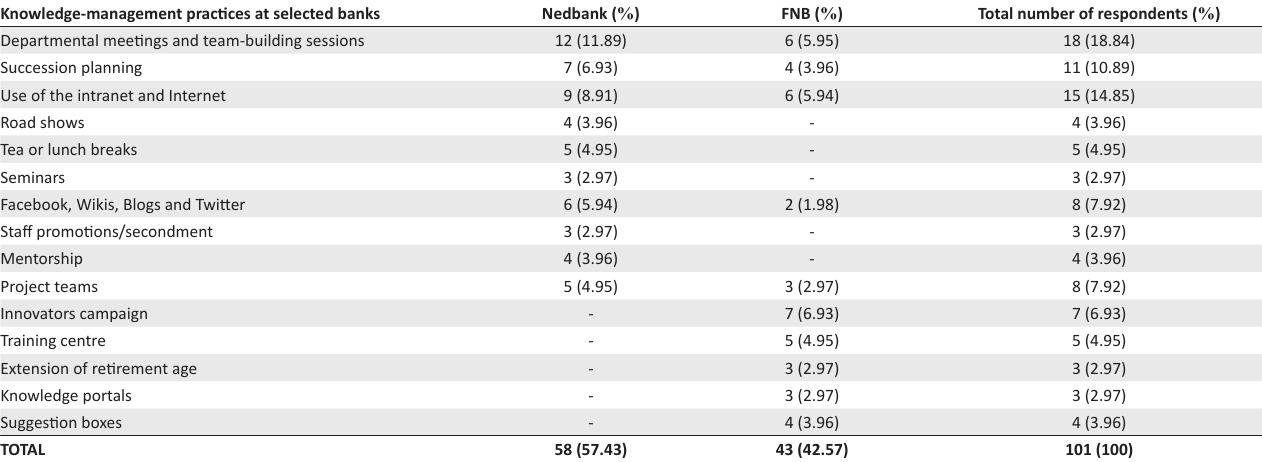
TABLE 1 Knowledge-management practices at selected banks. Knowledge-management practices at selected